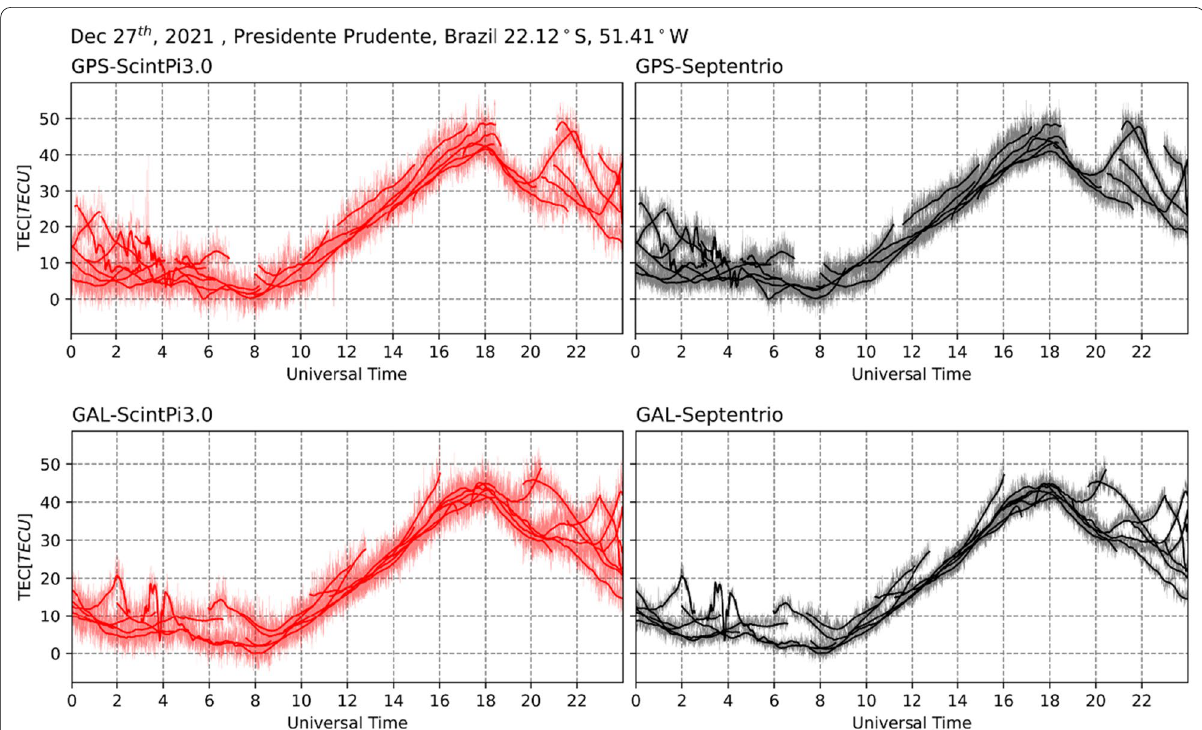
Fig. 9 Left panels: time variation of vertical TEC (VTEC) derived from ScintPi 3.0 measurements of GPS (top) and GALILEO (bottom) signals. Right panels: time variation of vertical TEC (VTEC) derived from PolaRx5S measurements of GPS (top) and GALILEO (bottom)